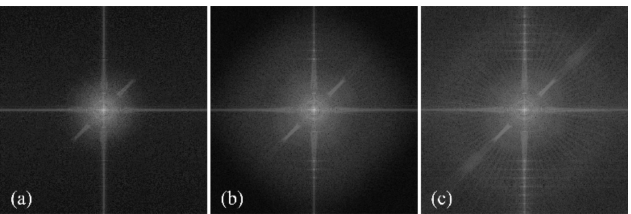
Figure 17. The logarithmic intensities of different results’ Fourier spectra. ( a ) The initialized spectrum. ( b ) The processed circular aperture image’s spectrum. ( c ) Our reconstructed image’s